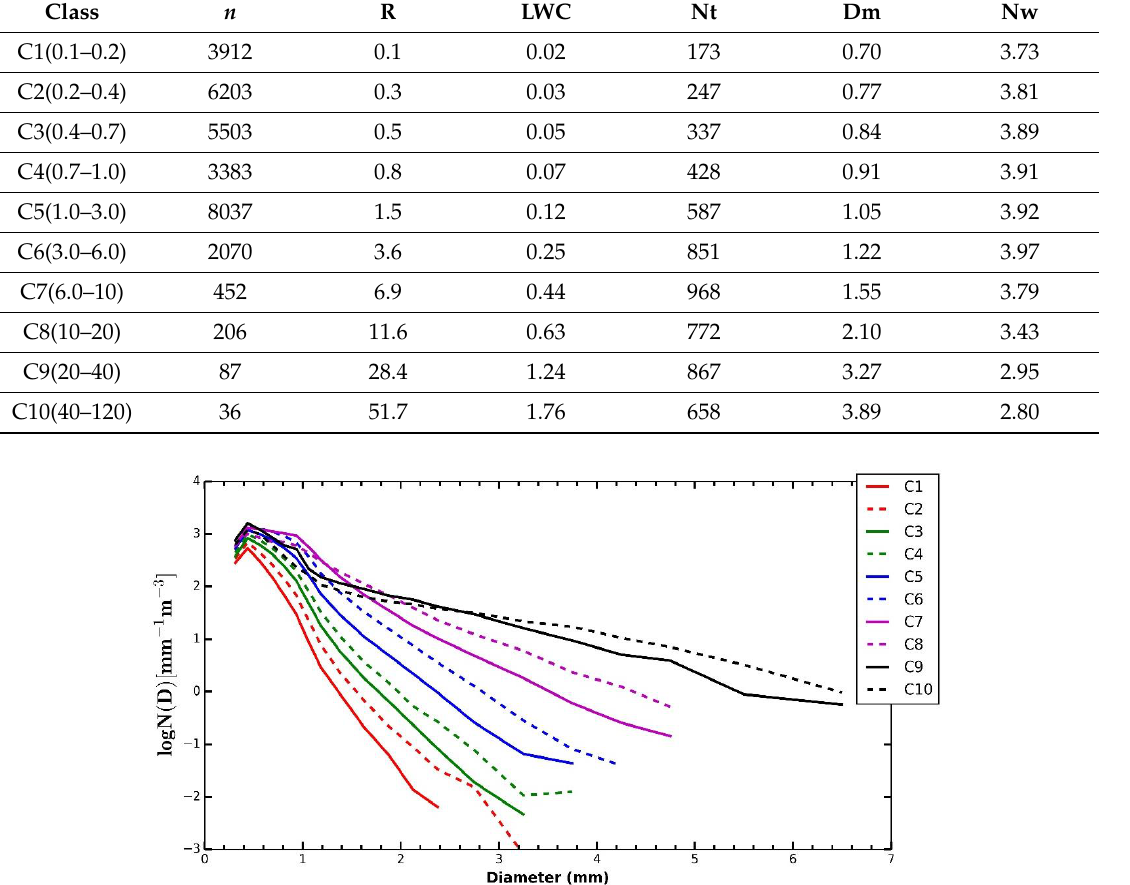
Table 1. Characteristics of the raindrops size distribution (RSD) in function of the rain rate class; number of cases ( n ) in each minute, rain rate (R [mm/h]), liquid water content (LWC[g/m3]), concentration total number (Nt [1/m 3 ]), mass-weighted mean diameter (Dm [mm]), intercept parameter (Nw [1/(mm m 3 )]). These variables were calculated for a period of 18 months between 2017 and 2019 registered by Parsivel2.